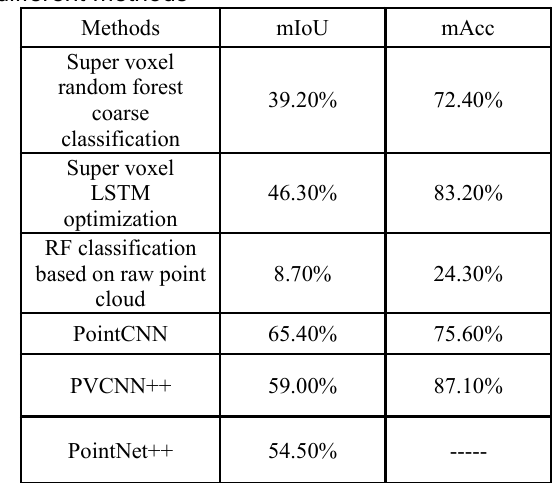
Table 2 Comparison of the classification accuracy